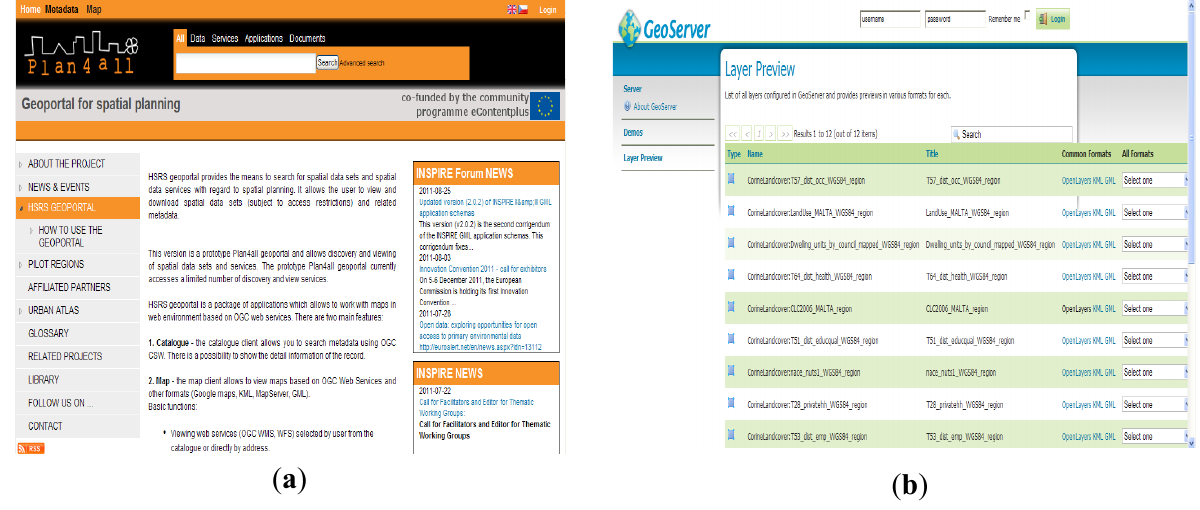
Figure 5. ( a ) Plan4all GeoPortal http://www.plan4all.eu/; ( b ) Malta (FTZ) Geoportal